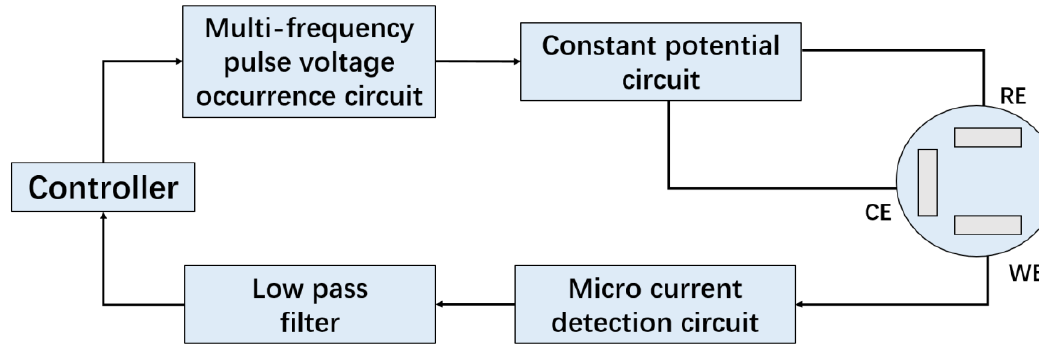
Figure 3. The structure of designed voltammetry electronic tongue hardware system. Table 1. The details of the electrode sensor array.